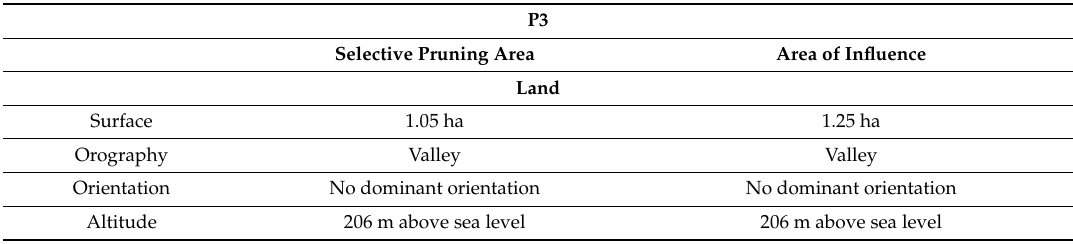
Table A3. Environmental features of each selected areas in P3 with specific regardto land (surface, orography, orientation, and altitude) and vegetation (vegetal composition and coverage, tree density, woodland age, and average level of damage by C. florentinus )